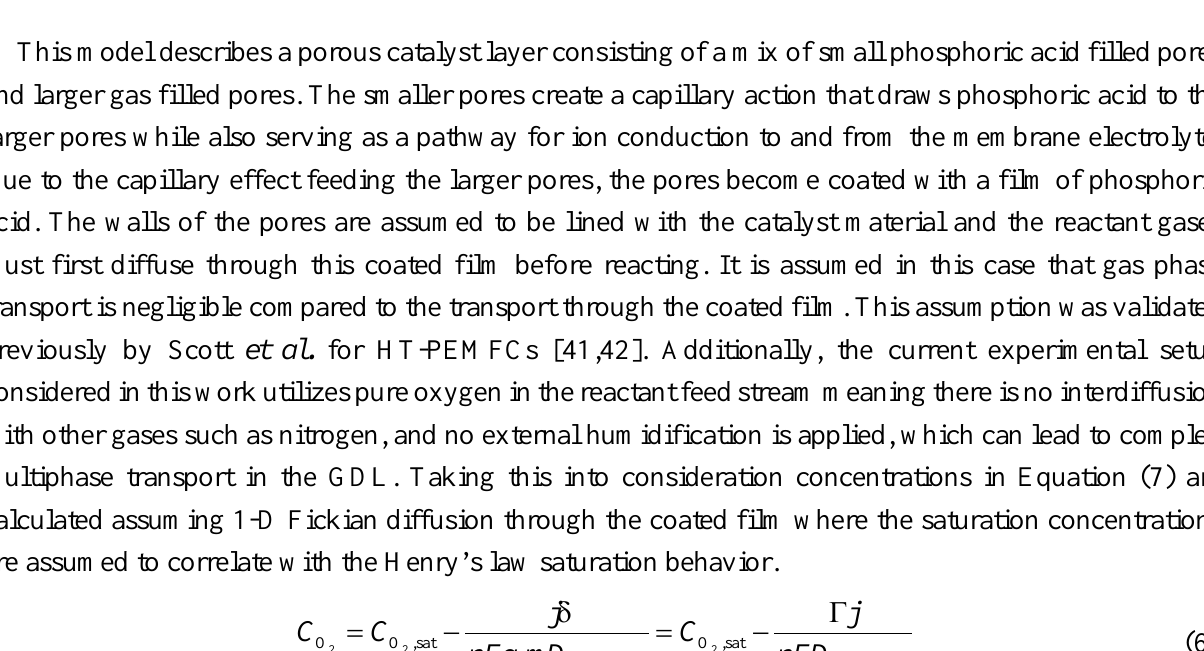
Figure 7. Depiction of the coated film model for the porous electrode (not drawn to